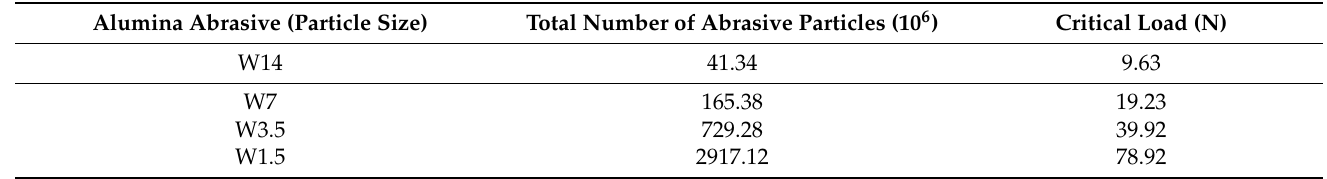
Table 3. Critical loads of LN crystal with different abrasive